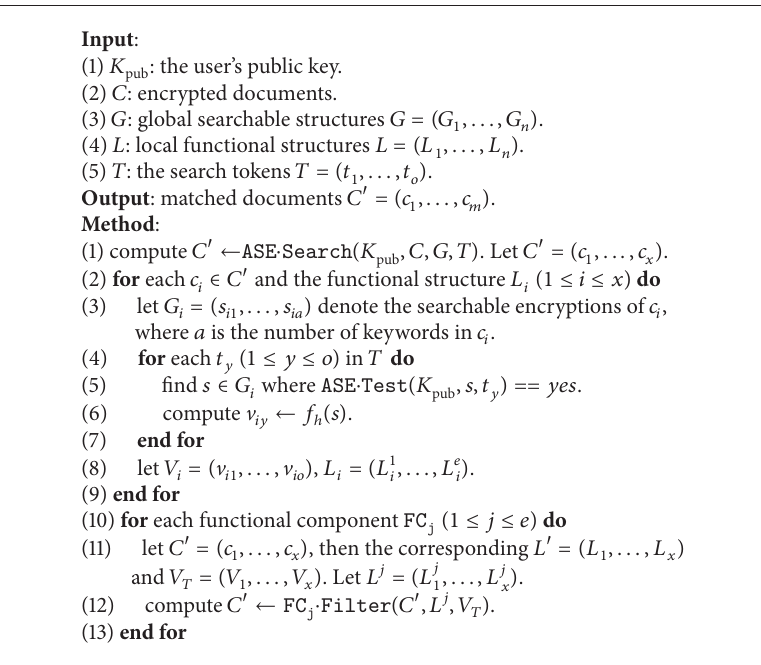
Algorithm 6: Search (asymmetric): Search (𝐾